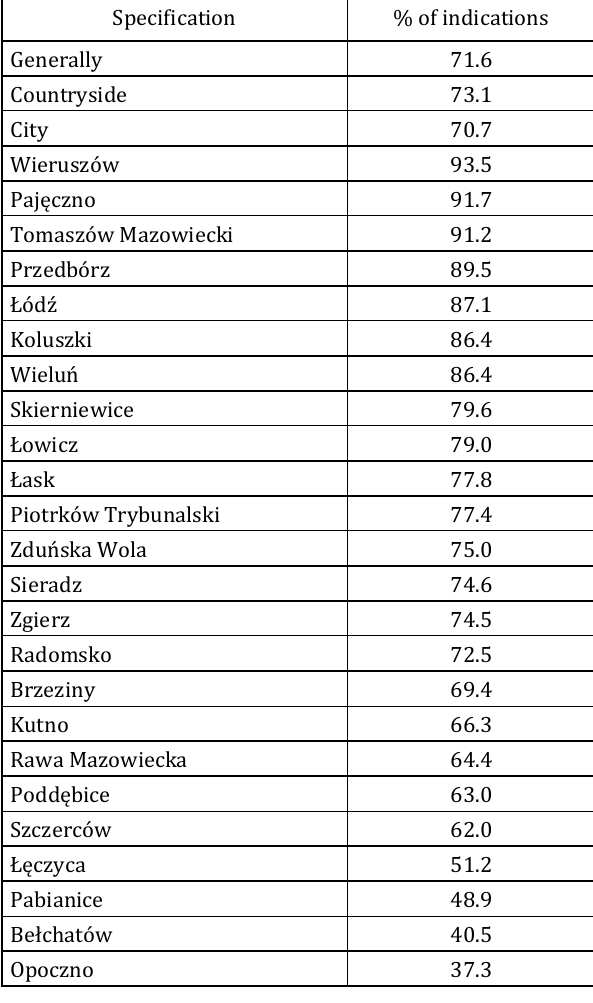
Table 1. The existence of wildlife conservation areas, according to students, in their areas of residence